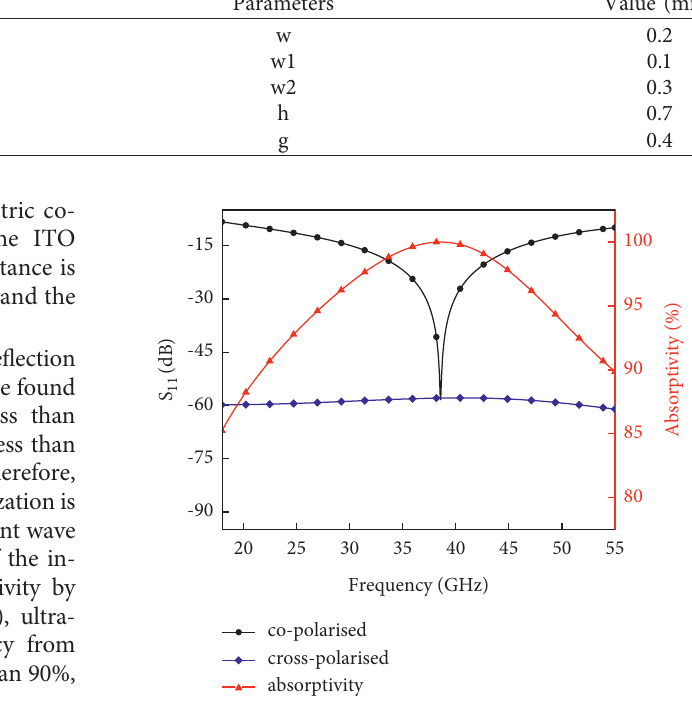
Figure 5: Simulated copolarized and cross-polarized S11 (left column) and absorptivity (right